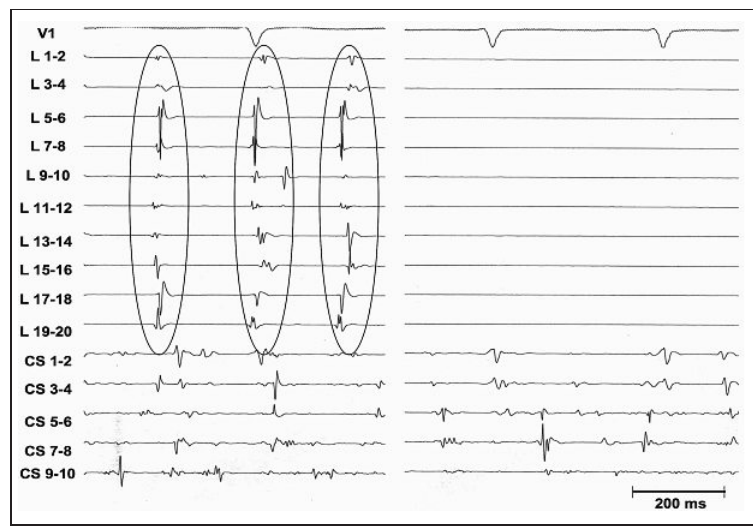
Left panel: Recording of PV potentials (encircled) on a circumferential mapping catheter (Lasso) in a patient with paroxysmal atrial fibrillation. Shown are one surface lead (V1), and intracardiac electrograms recording the multipolar ring catheter (L 1-2 (distal) to L 19-20 (proximal) in the left inferior PV, and the coronary sinus catheter (CS 1-2 (distal) to CS 9-10 (proximal).The patient was in atrial fibrillation during the procedure.There is chaotic atrial activity in the coronary sinus (CS) in atrial fibrillation. Right panel: During a freezing cycle with the cryoballoon at the left superior PV, all PV potentials on the Lasso catheter positioned in the left inferior PV disappeared.This is evidence of electrical interaction of the left superior and left inferior PV (crosstalk